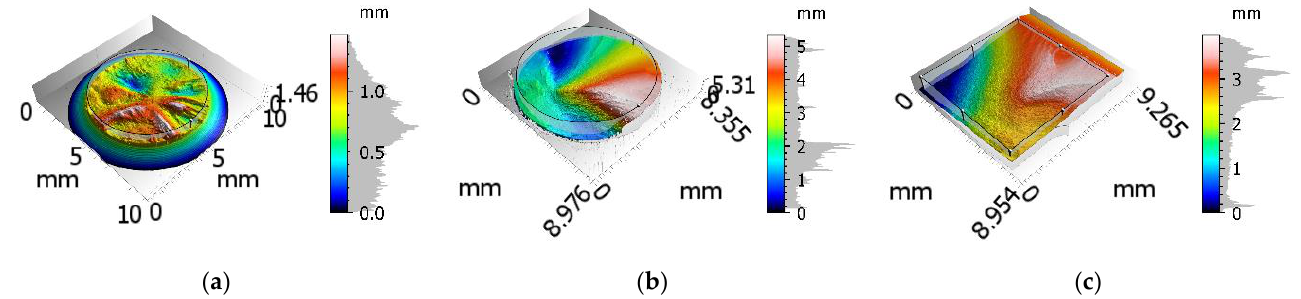
Figure 2. Methodology used to select the region of interest — ROI (all shown examples of fracture surfaces are for the bending-torsion case): ( a ) 10HNAP steel, ( b ) S355J2 steel, and ( c ) 2017-T4 aluminium alloy.